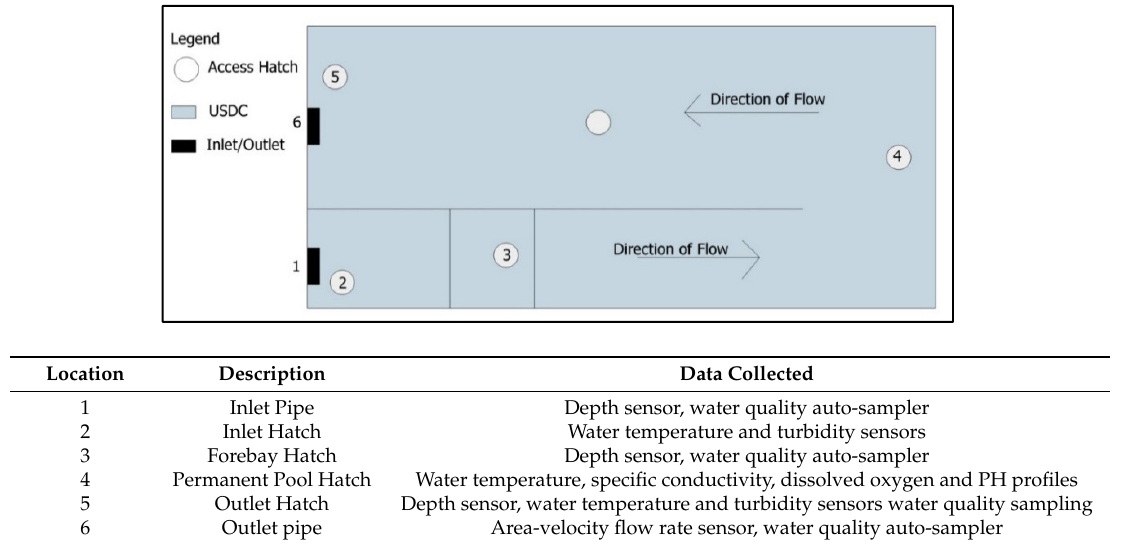
Figure 2. South Unionville USDC plan view with monitoring equipment layout.